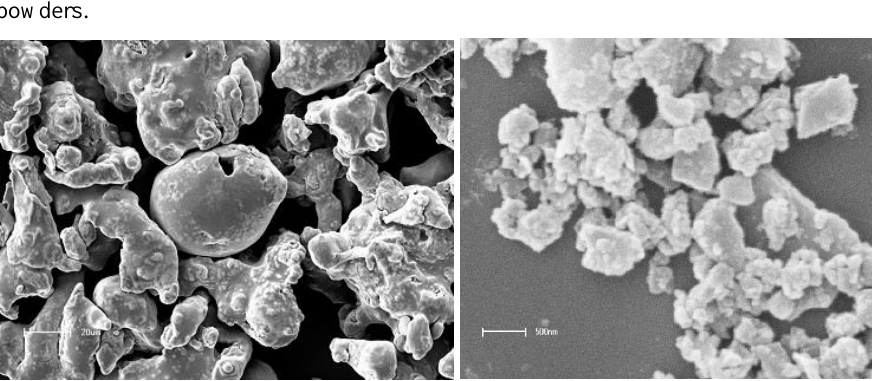
Fig. 2. Micrographs obtained by SEM: a) AISI 316L powder, b) boron carbide